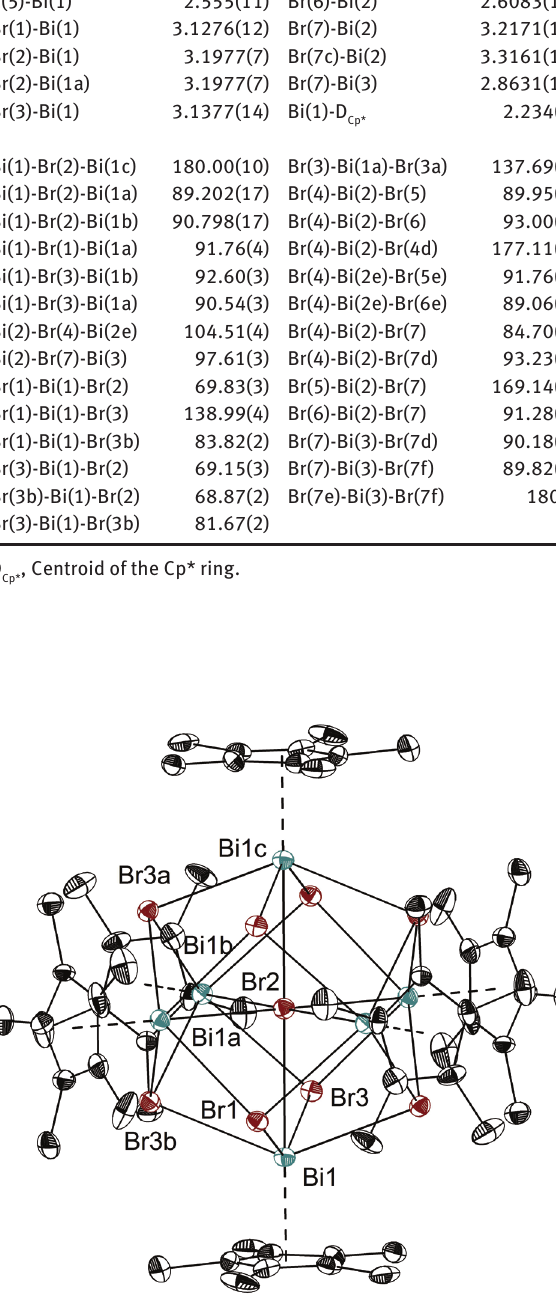
Figure 1 Thermal ellipsoid plot of the structure of the cationic part of 1 , [Bi Cp* Br ] 3+ ( 1a ). 6 6 9